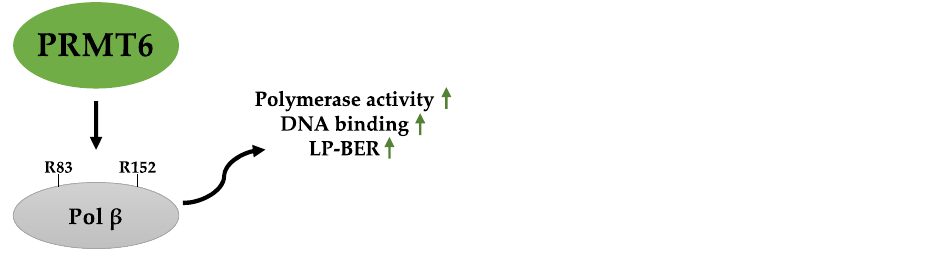
Figure 5. PRMT6-mediated methylation of Pol β enhances its activity and binding of DNA to promote LP-BER. Pol β , DNA polymerase β . Green arrows represent “increase”.